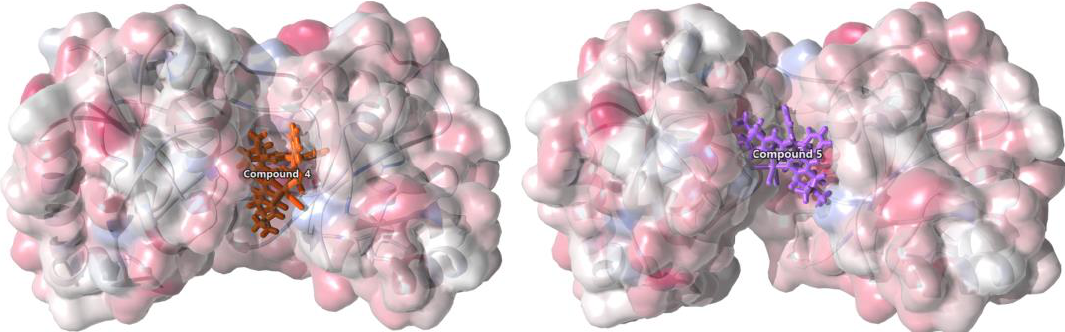
Figure 7. Representation of the structure of the homological model for SaMurG based on the residue hydrophobicity.